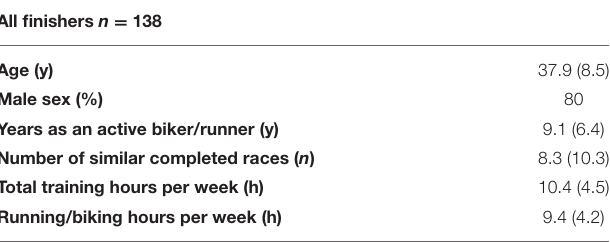
TABLE 1 | Demographic, pre-race, and experience-related characteristics of all the finishers ( n = 138) in each type of